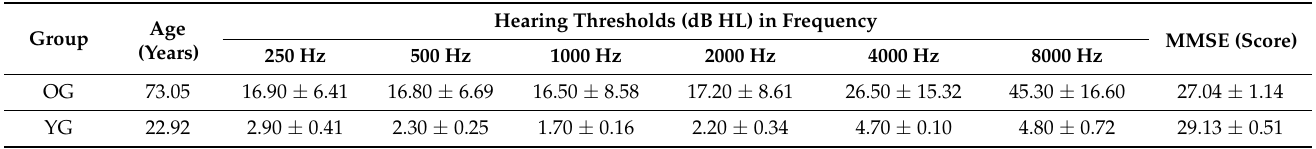
Table 1. A comparison of participant group mean and standard deviation for hearing sensitivity and MMSE. Group